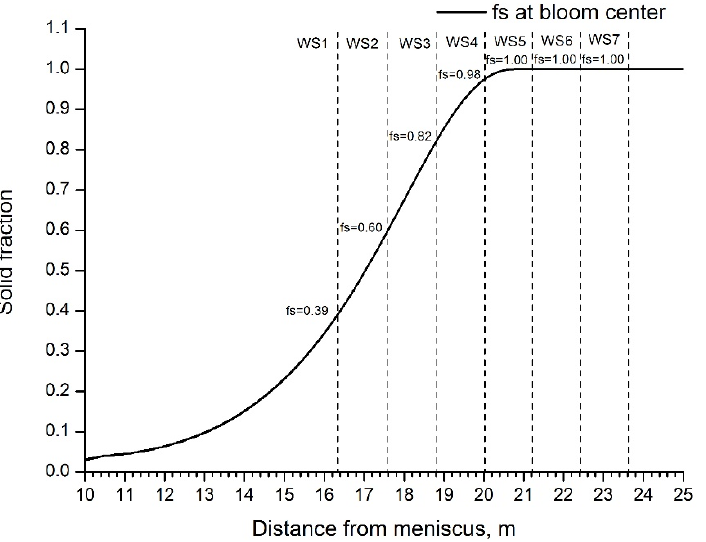
Figure 4. Simulated GCr15 bloom center solid fraction at different WS unit position.